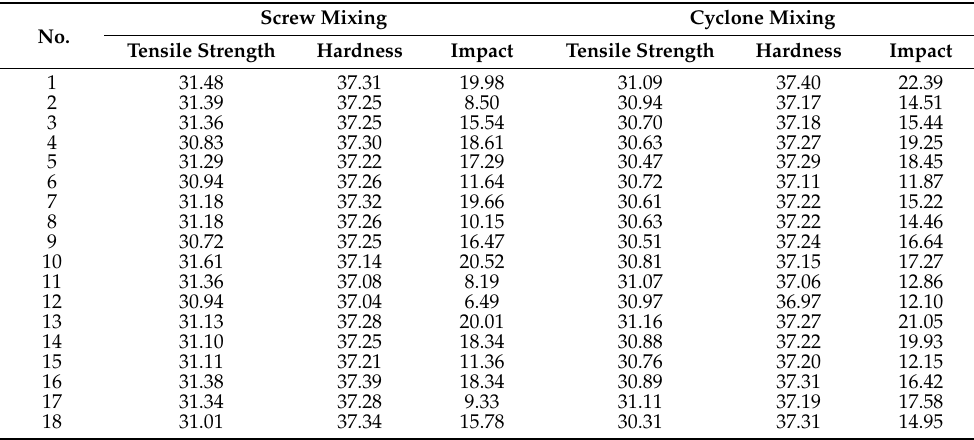
Table 3. Quality characteristics S/N ratio larger-the-better analysis.